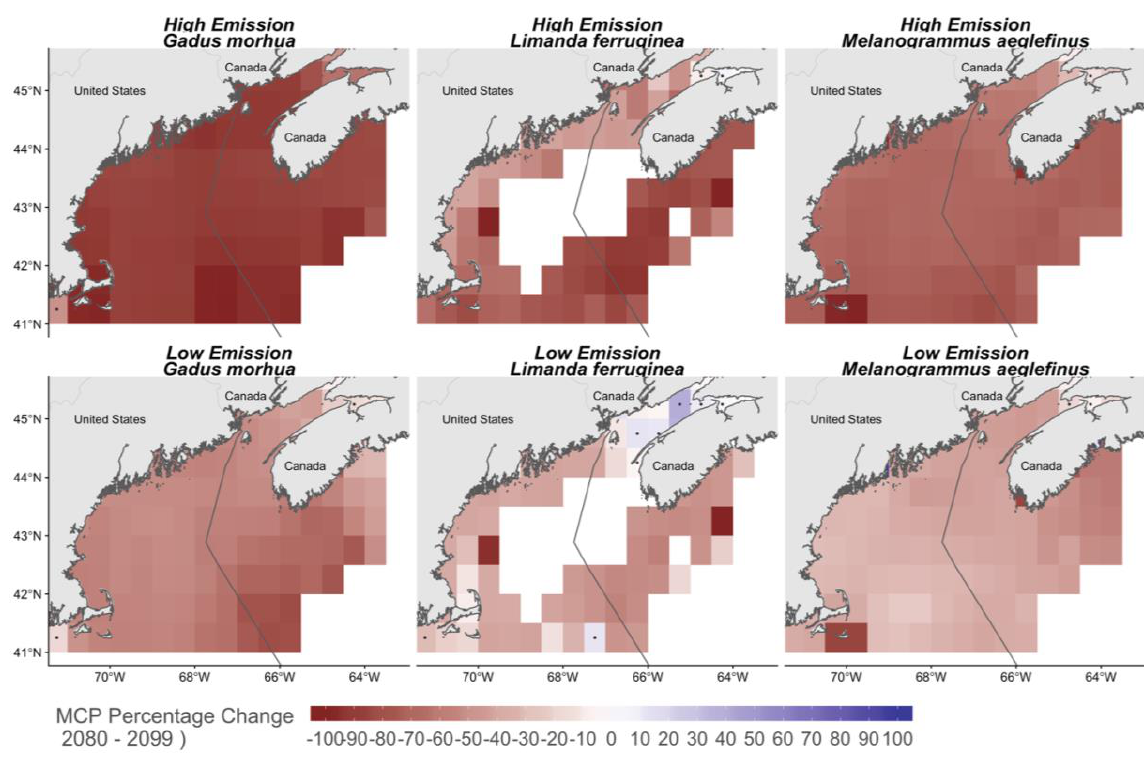
Fig. A1.2. Percentage change of MCP in the Gulf of Maine under (RCP 8.5) high emission scenario and (RCP 2.6) low emission for end-century (2080–2100) relative to present (2005– 2014). Values represent the mean of 3 ESM. Points represent regions where ESMs do not agree in direction of